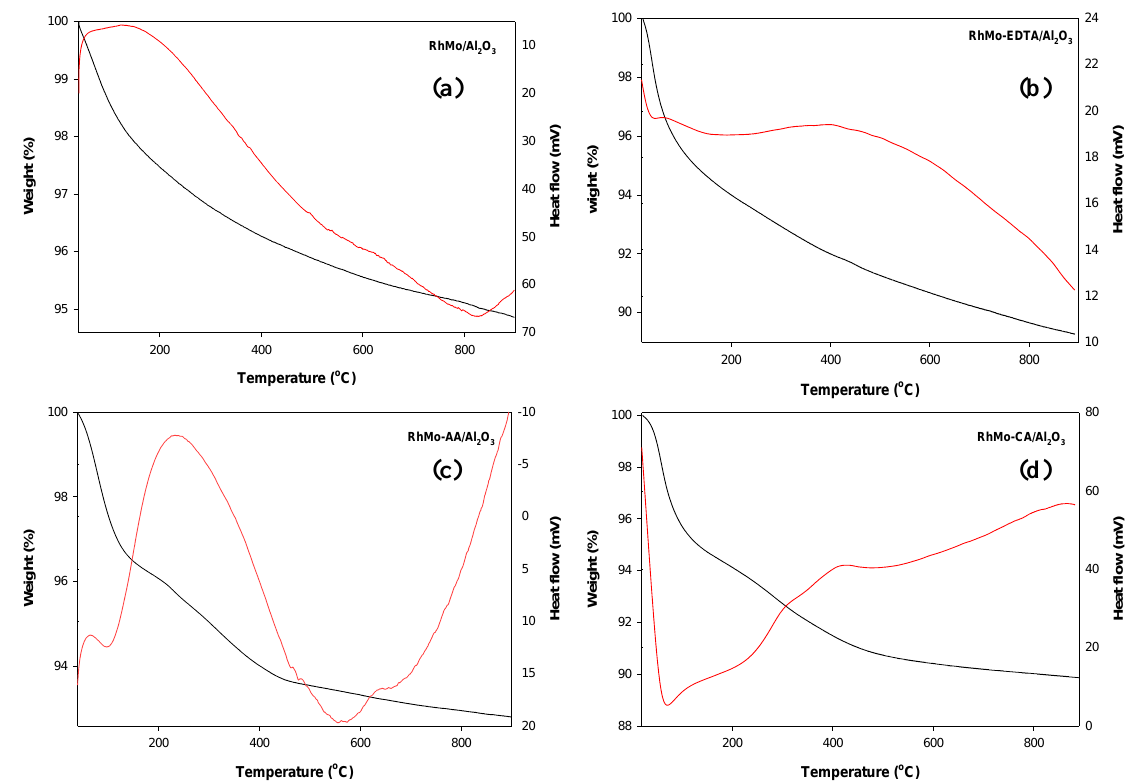
Figure 8. TGA-DSC curves of ( a ) RhMo/ ɣ -Al 2 O 3 , ( b ) RhMo-EDTA/ ɣ -Al 2 O 3 , ( c ) RhMo-AA/ ɣ -Al 2 O 3 , ( d ) RhMo-CA/ ɣ -Al 2 O 3 catalysts.